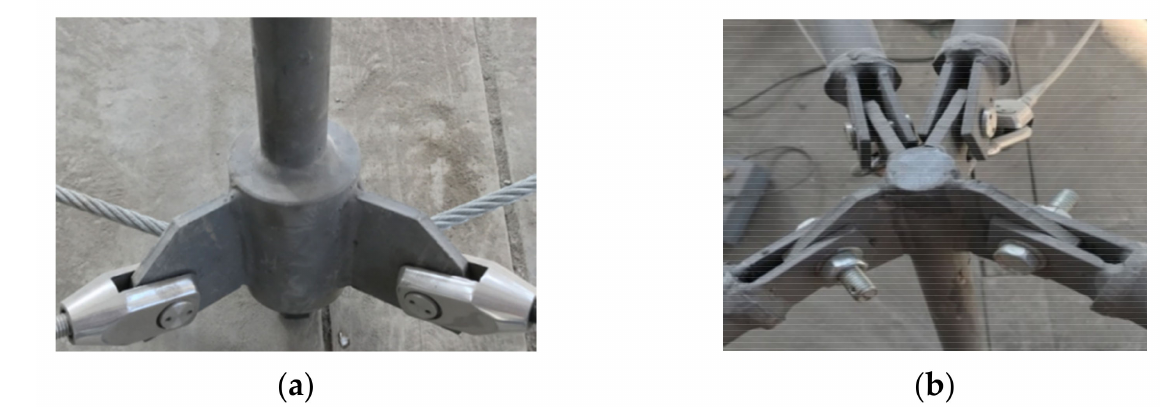
Figure 9. Photographs of the connecting joints. ( a ) Lower joint; ( b ) Upper